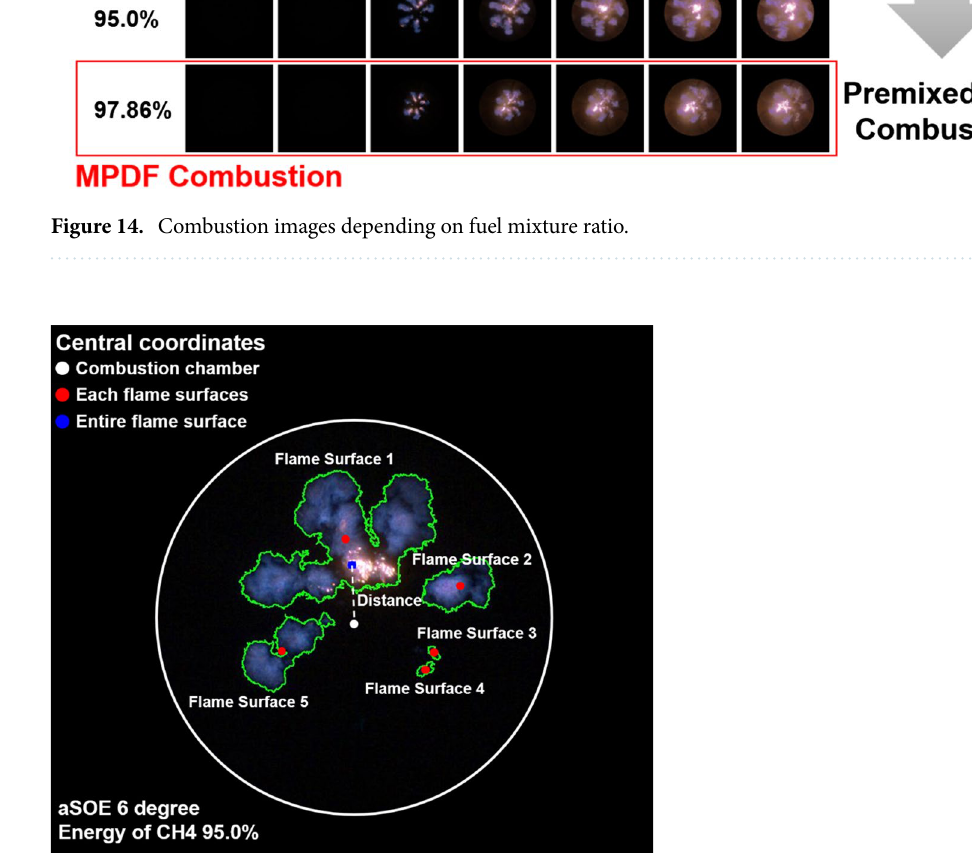
Figure 15. Central coordinates of combustion chamber, each flame surfaces and entire flame